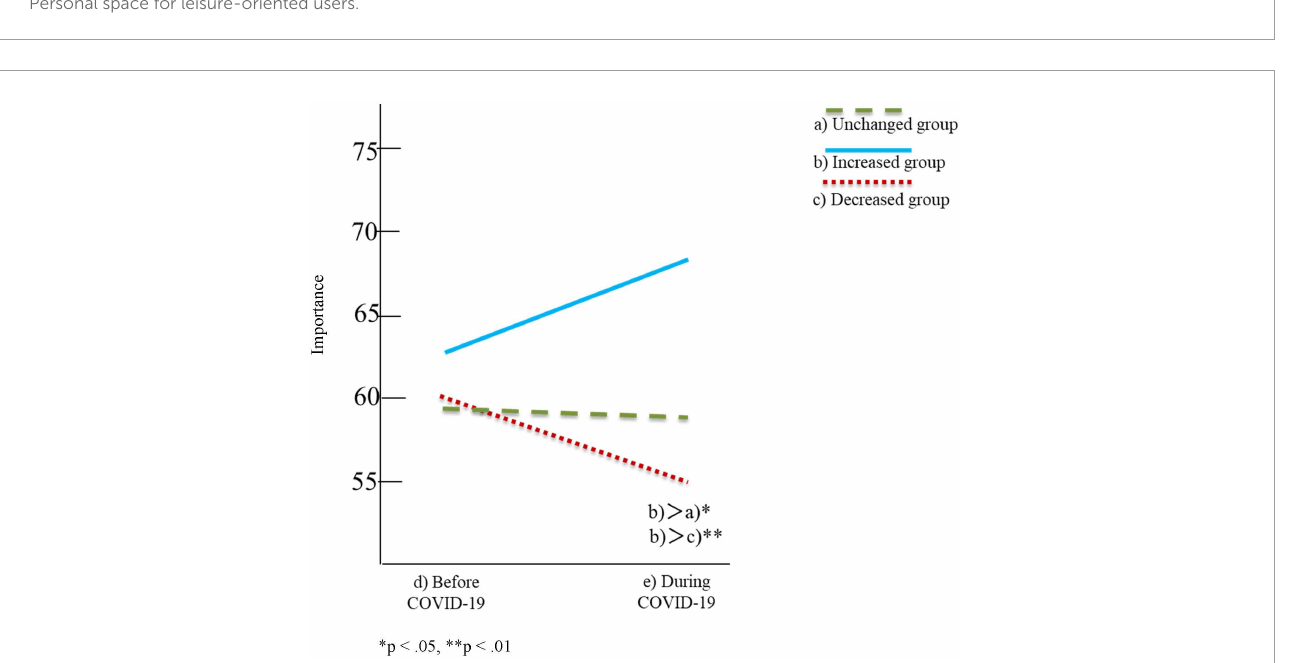
COVID-19 ( M = 68.06, SD = 23.35) was significantly higher than those of the unchanged ( M = 59.26, SD = 26.68) and decreased groups ( M = 55.44, SD =